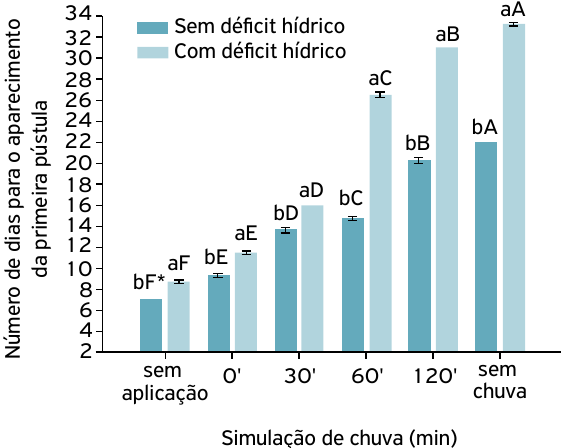
Figura 1. Número de dias para o aparecimento da primeira pústula de Phakopsora pachyrhizi na interação entre regimes hídricos e intervalos de simulação de chuva após a aplicação de fungicidas. Itaara – RS,